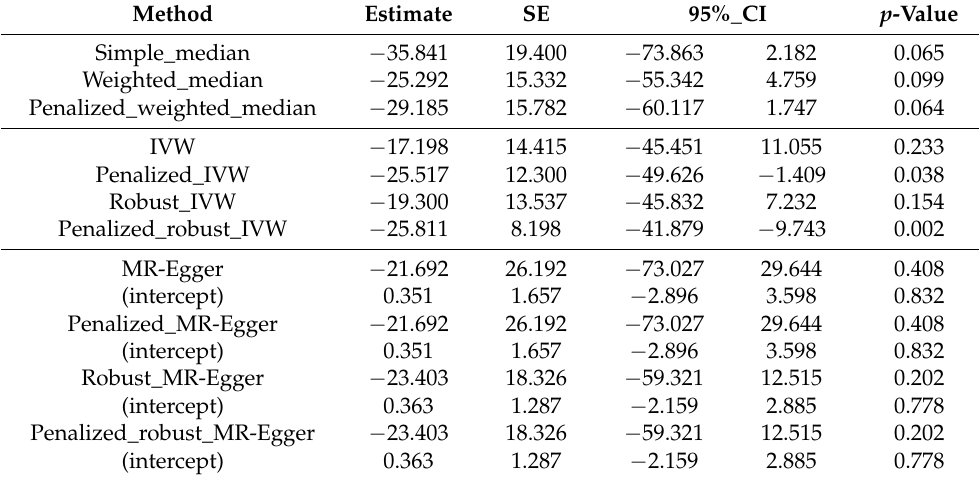
Figure 1. Scatter plot of genetic associations with gut microbiome against the genetic association with outcome (fasting plasma glucose for the nine preselected instruments—indicated SNPs). SNP: Single nucleotide polymorphism. Table 5. Mendelian randomization estimates for each method of the so-called “causal” effect of gut microbiome (nine selected instruments on fasting plasma